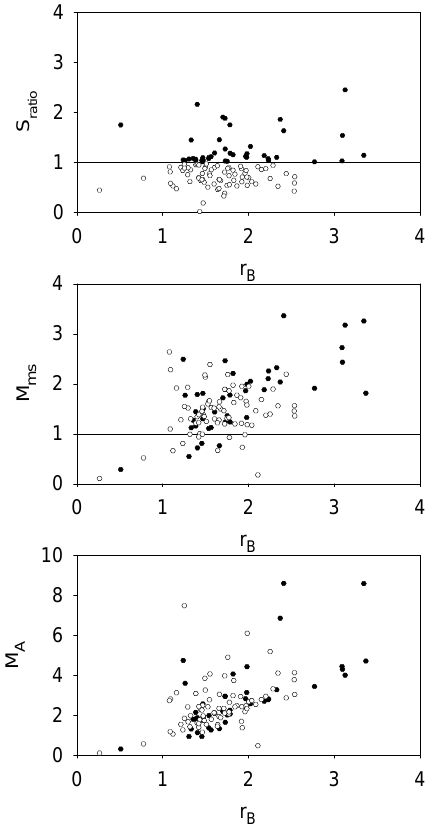
Fig. 5. These results are obtained using 1 hour up and downstream data (cid:3)(cid:4) . Top panel shows the entropy periods for a 3 component plasma and (cid:0)(cid:5)(cid:1) , middle panel magnetosonic Mach number against , and ratio against (cid:9)(cid:11)(cid:10) (cid:9)(cid:11)(cid:10) bottom panel Alfv´en Mach number against . Filled circles have entropy (cid:9)(cid:10) increases and open circles have entropy decreases.